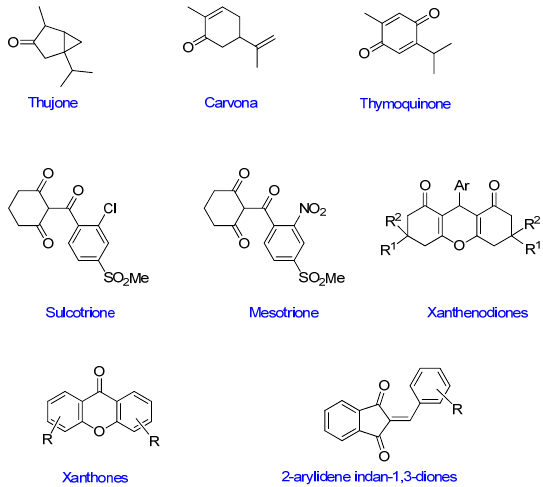
Figure 1. Structures of cyclic ketones.